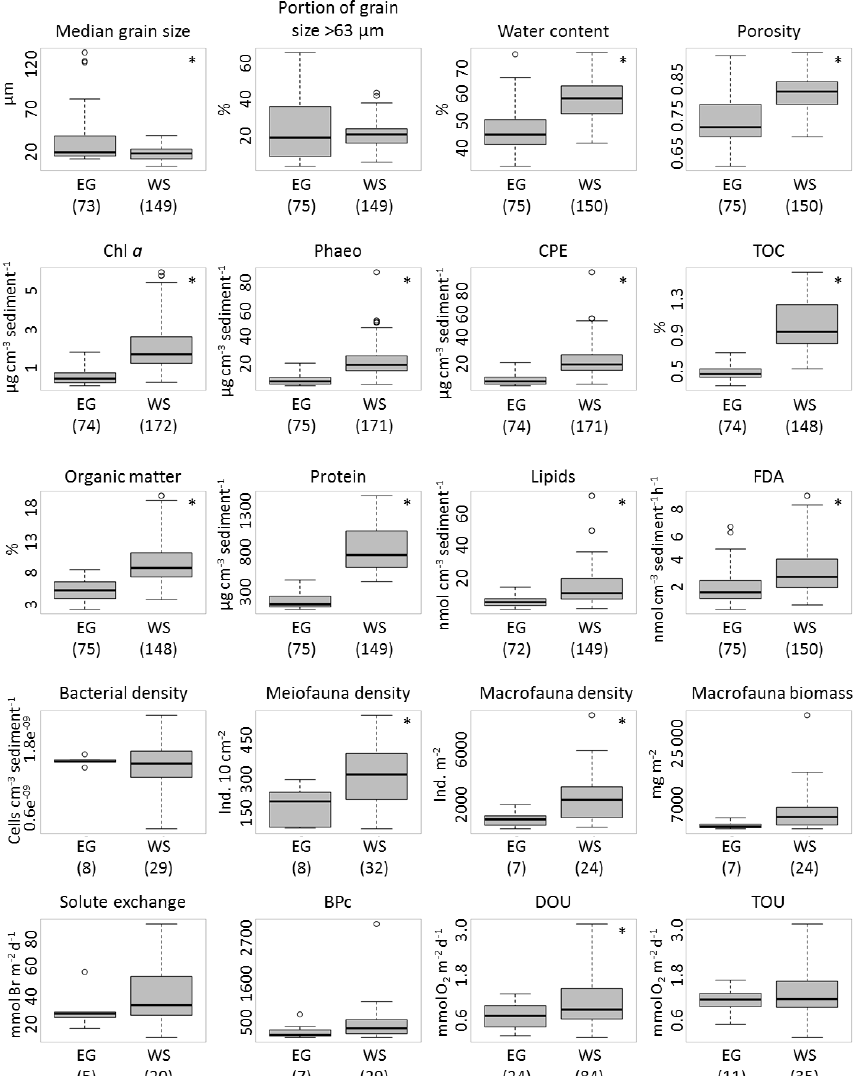
Figure 3. Box plots of sediment properties, biogenic compound values (Chl a is chlorophyll a , Phaeo is phaeophytin, CPE is chloroplastic pigment equivalents, TOC is total organic carbon, FDA is bacterial enzymatic turnover rates calculated using the fluorogenic substrate fluorescein-di-acetate), benthic community data and function (BP c is the bioturbation potential), and oxygen fluxes (DOU is the diffusive oxygen uptake, TOU is the total oxygen uptake), of the east Greenland (EG) and west Spitsbergen (WS) areas. For a detailed description of which stations were included at which site, see Sect. 2.1. The number of observations is given in brackets below the area. Parameters showing significant differences between areas are marked with an asterisk. For comparability, the WS site does not contain values from SV I